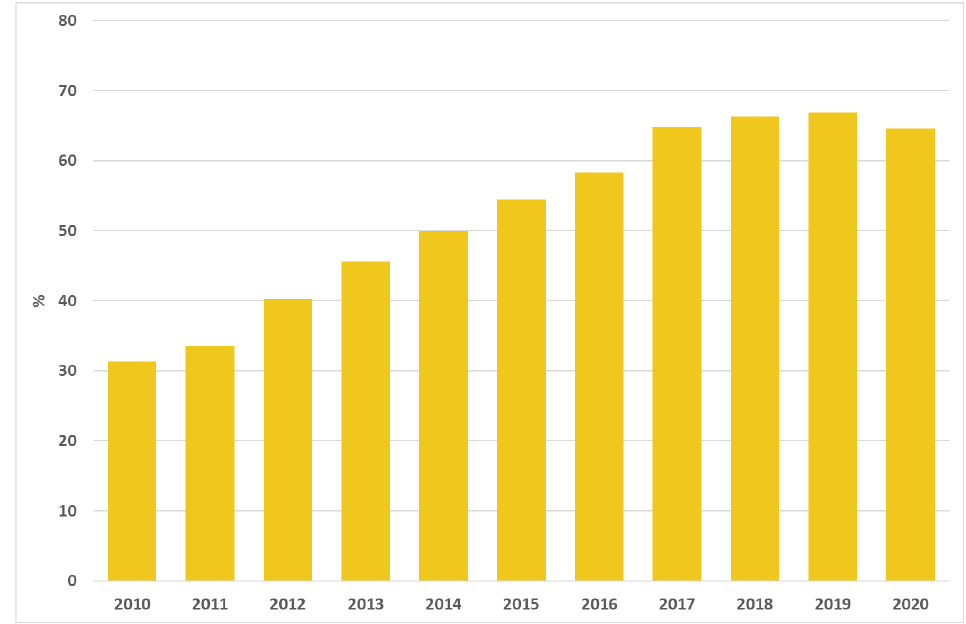
Figure 1. Proportion of surgery within 2 days after hip fracture in patients over 65 years of age. Italy, 2010–2020.